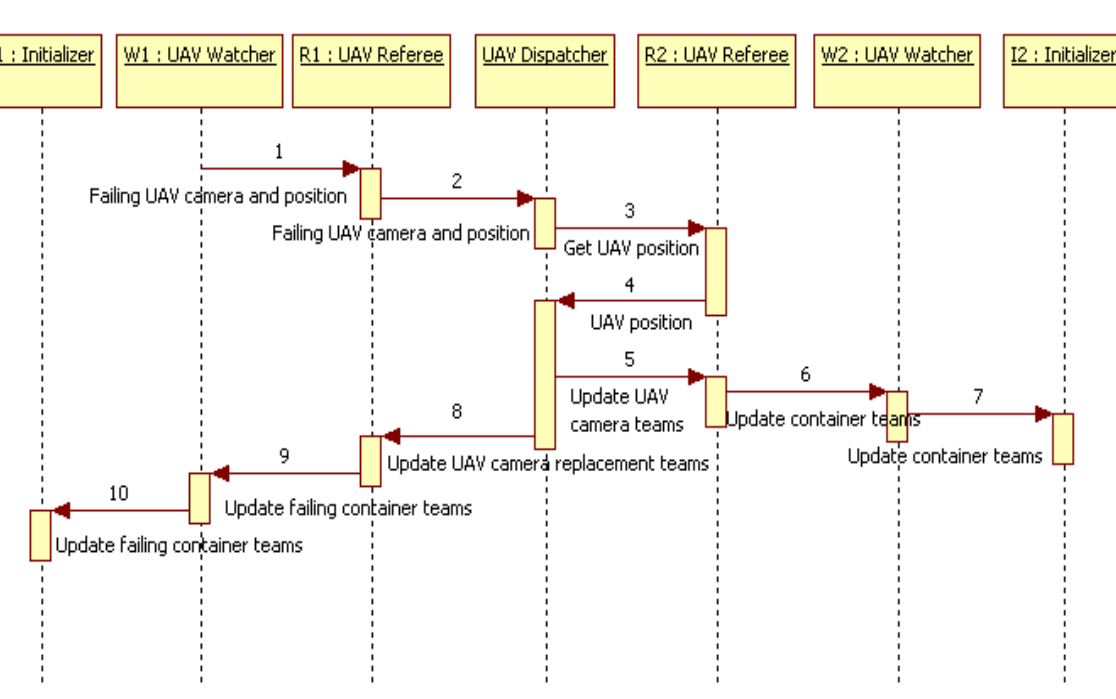
Figure 4. Replacement of an UAV camera serving an